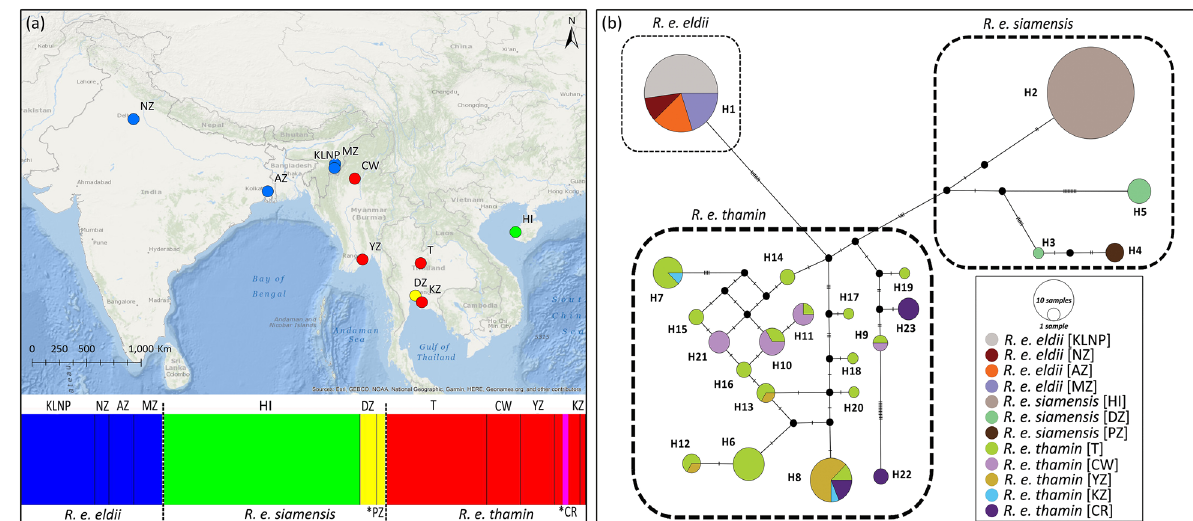
Figure 2. ( a ) Bayesian analysis of population structure (BAPS) of Eld’s deer ( Rucervus eldii ) subspecies identified four genetic clusters using 200 mitochondrial control region sequences. Clusters are represented by colours. The dashed black lines separate subspecies and solid black lines separate populations. The map was created using ArcGIS v.10.3.1 software developed by ESRI (https ://www.esri.com). ( b ) Median-joining haplotype network for 23 control region haplotypes identified among the three Eld’s deer subspecies. Three major clusters were recovered and are indicated by subspecies names. Circle size represents the frequency of individuals, and colour defines the populations. Small black circles represent median vectors. Mutational steps are shown by bar on the respective branches. The populations are abbreviated as KLNP Keibul Lamjao National Park, Manipur; NZ National Zoological Park, New Delhi; AZ Alipore Zoological Garden, West Bengal; MZ Manipur Zoological Garden, Manipur; HI Hainan Island, China; DZ Dusit Zoo, Thailand; *PZ Paris Zoo, France (not shown in map); T Thailand; CW Chatthin Wildlife Sanctuary, Myanmar; YZ Yangon Zoo, Myanmar; KZ Khao Khew Open Zoo, Thailand; *CR Conservation & Research Centre, USA (not shown in